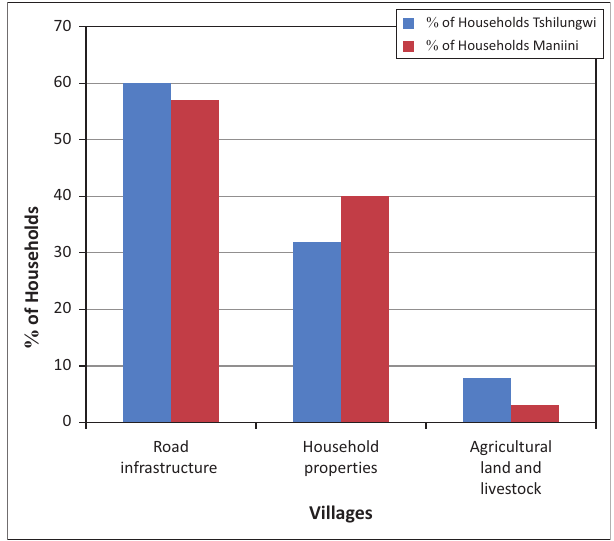
FIGURE 3: Flood damage at Tshilungwi and Maniini Villages, December 2010 and January 2011.